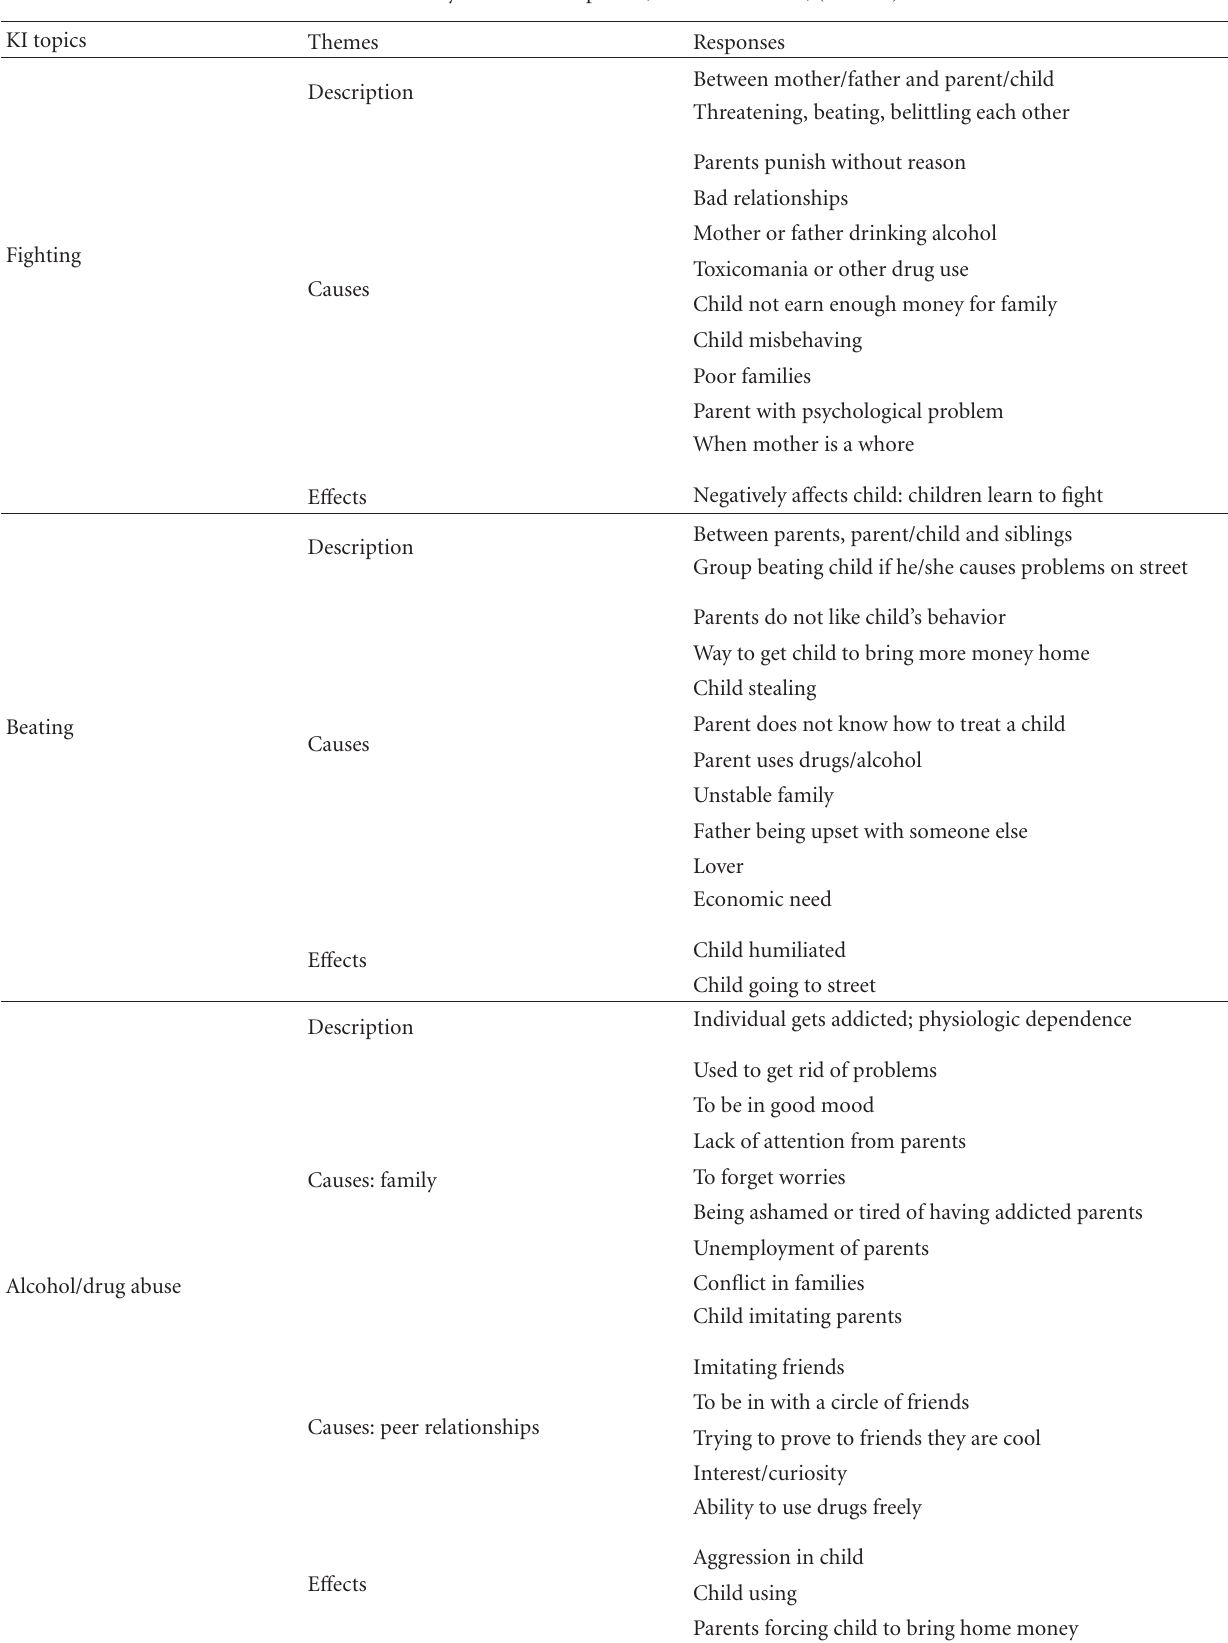
Table 3: Key informant responses, across all centers, ( N =